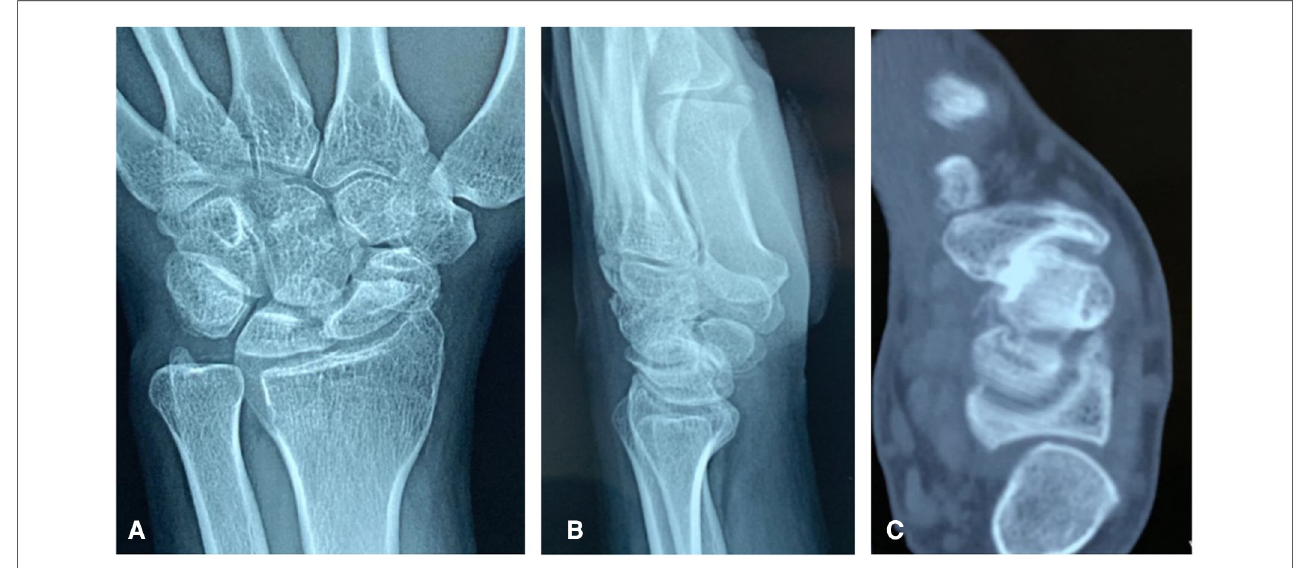
FIGURE 1 Preoperative anteroposterior ( A ) and lateral ( B ) x-ray and sagittal CT scan ( C ) of a scaphoid fracture nonunion with a